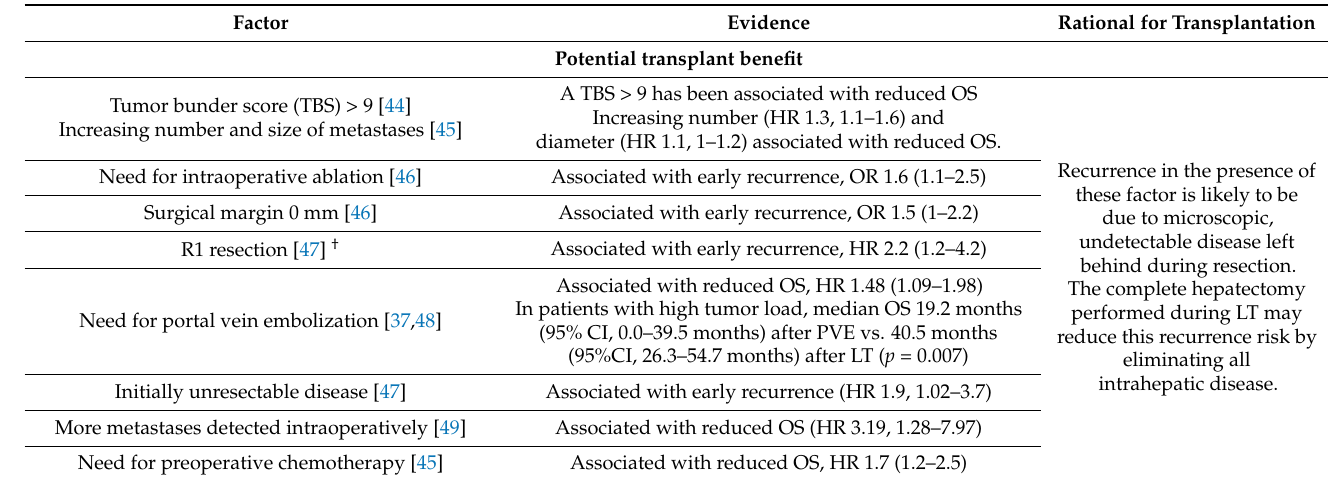
Table 3. Factors associated with biological